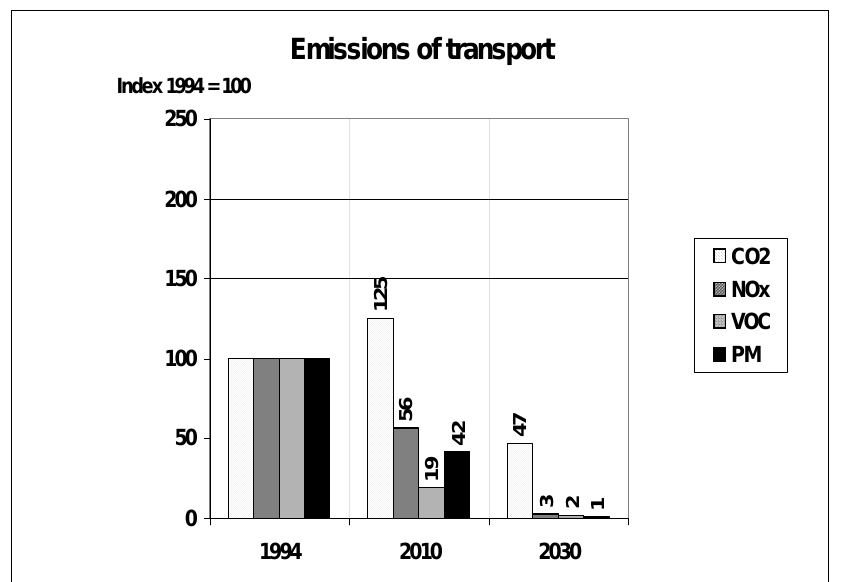
Figure 7. Current and projected emissions from transport under the Environmentally Sustainable Transport scenario for the CEI